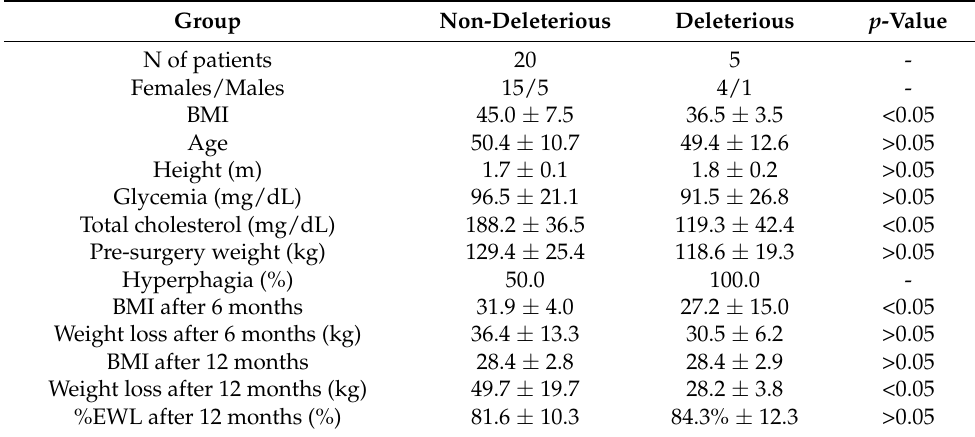
Table 1. Weight loss of bariatric surgery patients after 6 and 12 months since bariatric surgery. Pre-surgery clinical data on weight, BMI, hyperphagia, glycemia and total cholesterol are reported. Patients were divided in two groups, based on the pathogenicity classification of the genetic variant identified with the NGS sequencing. Data were analyzed with independent samples t -test analysis. Group Non-Deleterious Deleterious p -Value N of